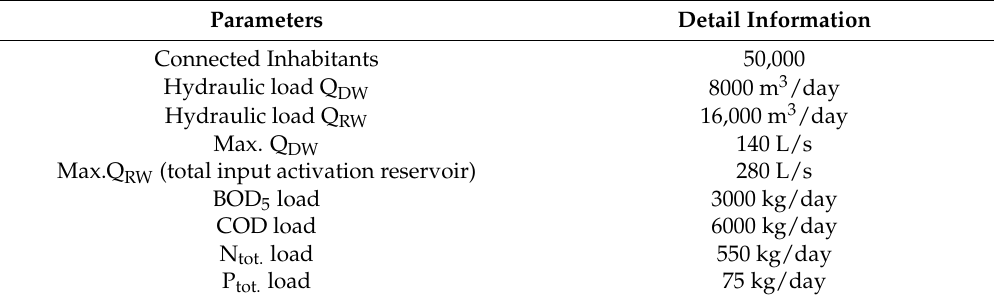
Table 1. Specific parameters of the investigated wastewater treatment plant